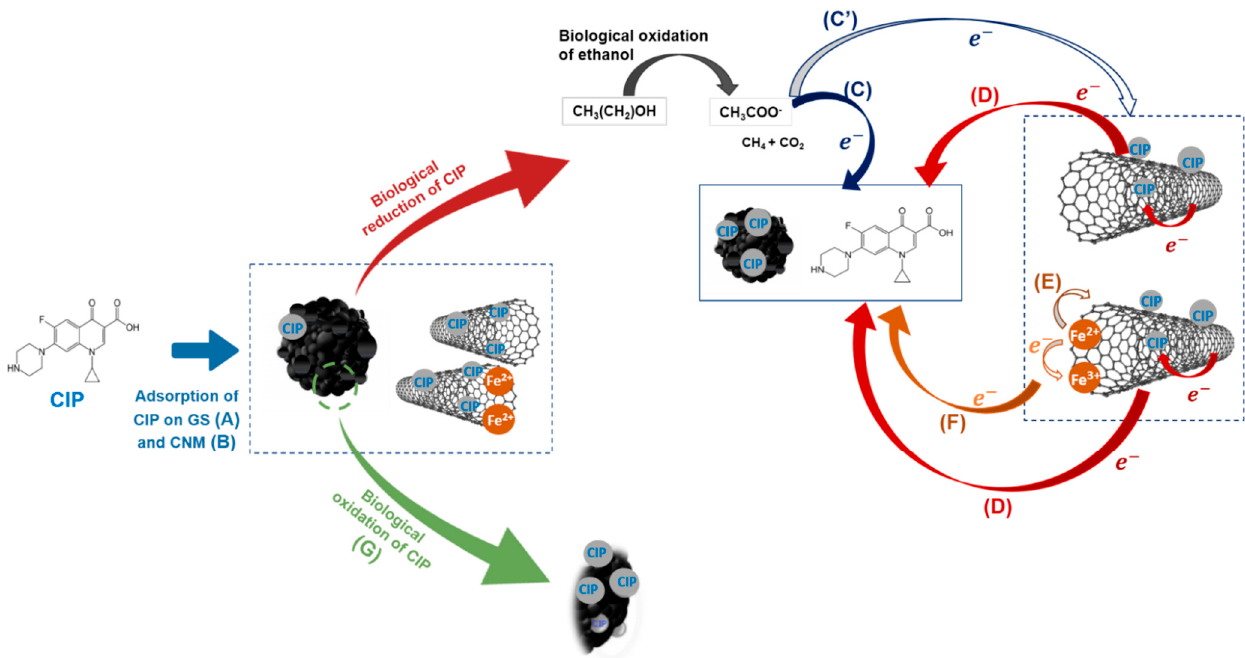
Figure 3. Proposed mechanisms of CIP removal: adsorption of CIP on GS (A) and on CNT or on CNT@2%Fe (B); biological reduction due to electron (e − ) flow from the biological oxidation of ethanol to CNM (C’) or CIP (in solution and/or adsorbed on sludge) (C); biological reduction in the presence of CNM (D) due to e − transfer from the oxidation of ethanol to CNM and then to CIP (in solution or adsorbed on sludge or on CNM), and due to e − transfer to CNT from the abiotic oxidation of Fe 2+ (E) and then to CIP (adsorbed or in solution) (F). Further, oxidation of CIP (in solution and adsorbed on sludge) by the anaerobic microorganisms may occur (G). All these mechanisms may occur independently or combined.